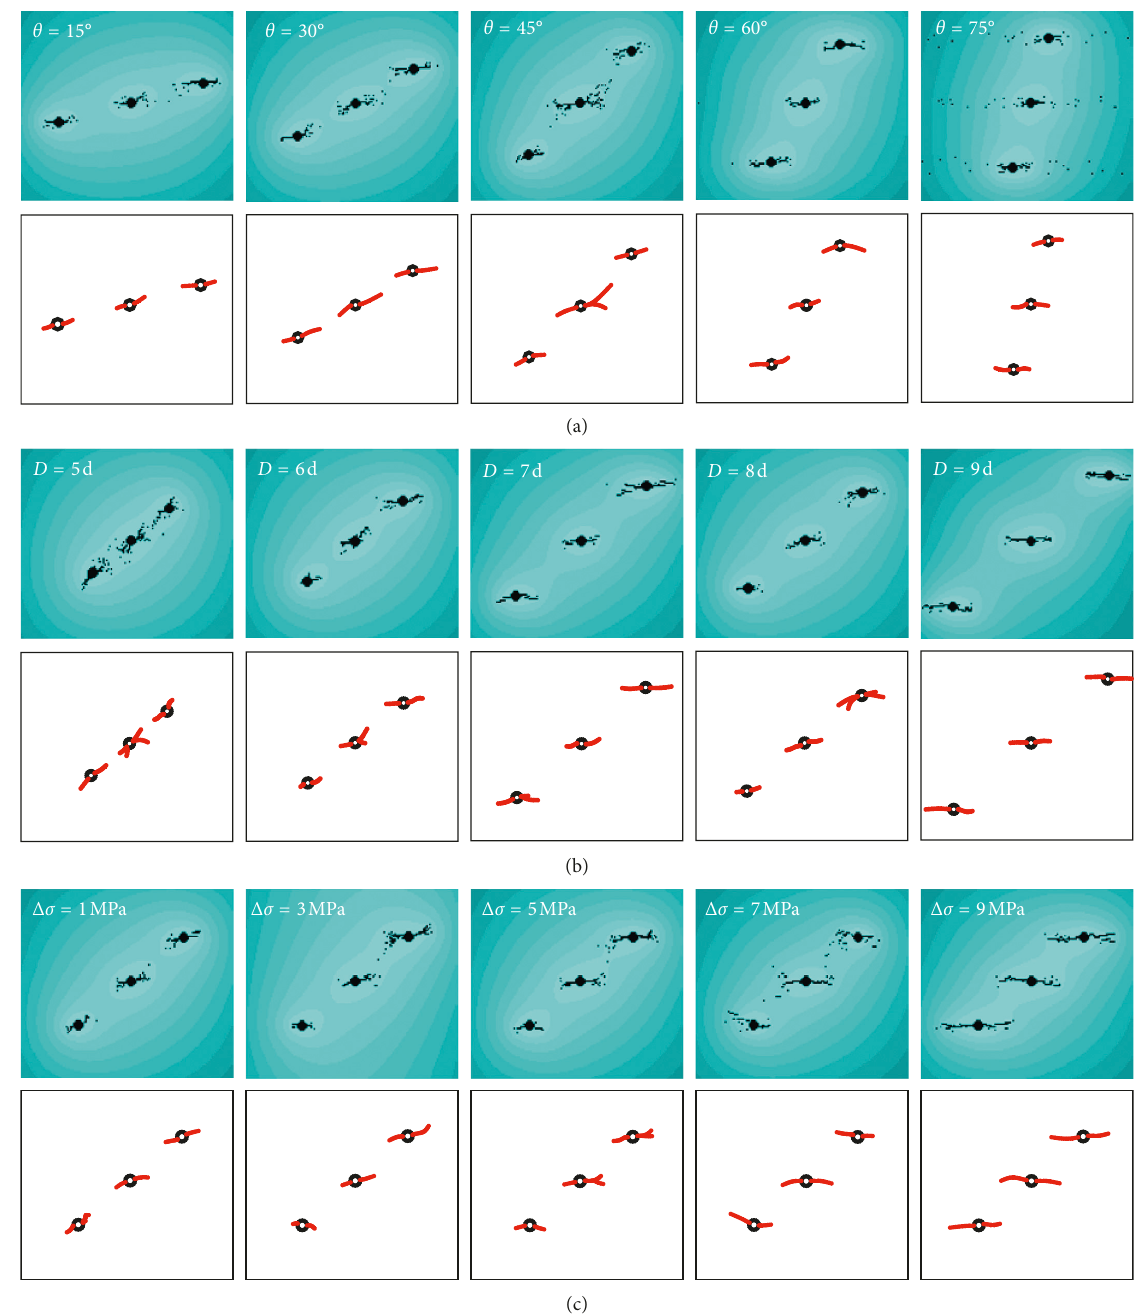
Figure 7: Crack initiation of directional hydraulic fracturing controlled by dense linear multihole drilling with various parameter values. (a) Angle θ between borehole direction and σ 1 . (b) Borehole spacing D . (c) Difference in principal stress Δ σ